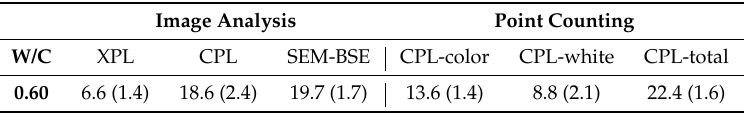
Table 2. Image analysis and point counting results overview of the XPL, CPL and SEM-backscattered electron detection (BSE) photomicrographs (in area%). Standard deviations are given between the